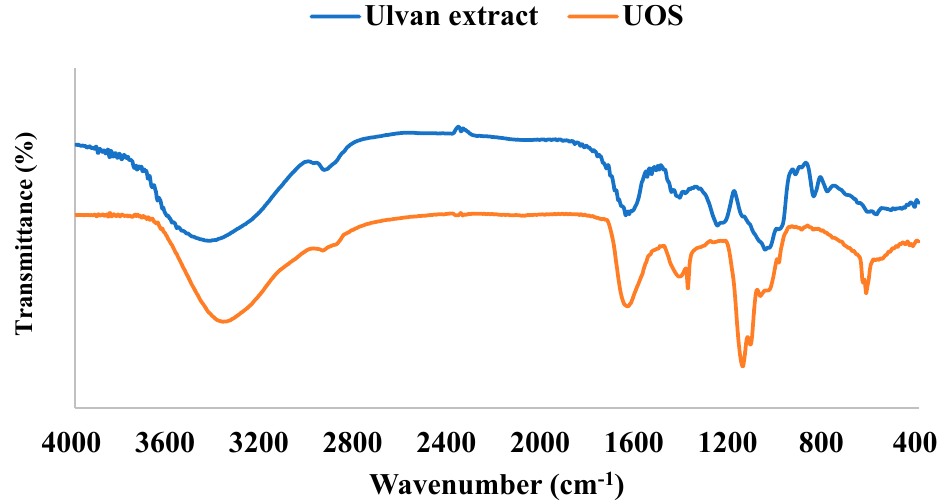
Figure 3. FT-IR chromatogram of ulvan extract (blue) and UOS (orange). (Sample:KBr = 1:99; wave range: 400–4000 cm − 1 ).